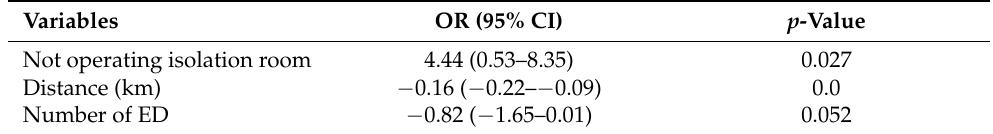
Table 5. Analysis of factors affecting the